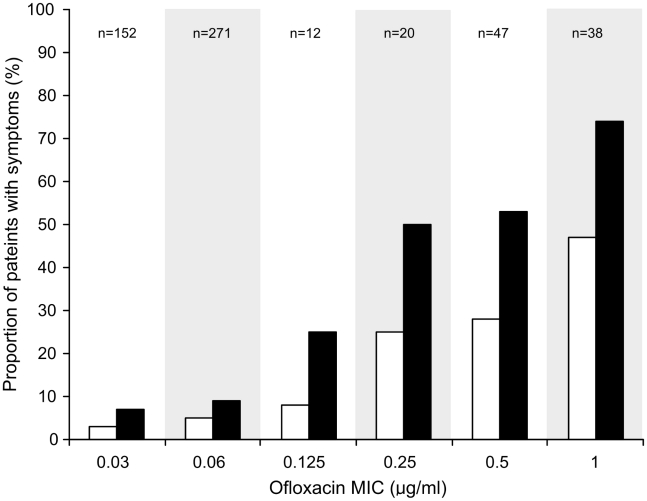
The relationship between increasing S. Typhi MIC to ofloxacin and clinical failure.Histogram showing the proportion of enteric fever patients who failed treatment (white columns) or had persistent fever (black columns) (>38°C) for more than seven days after the commencement of treatment. Data was combined from seven randomised clinical trials and is comprised from 540 children and adults recruited with uncomplicated enteric fever. The patients are divided according to the MIC to ofloxacin of the infecting isolate.